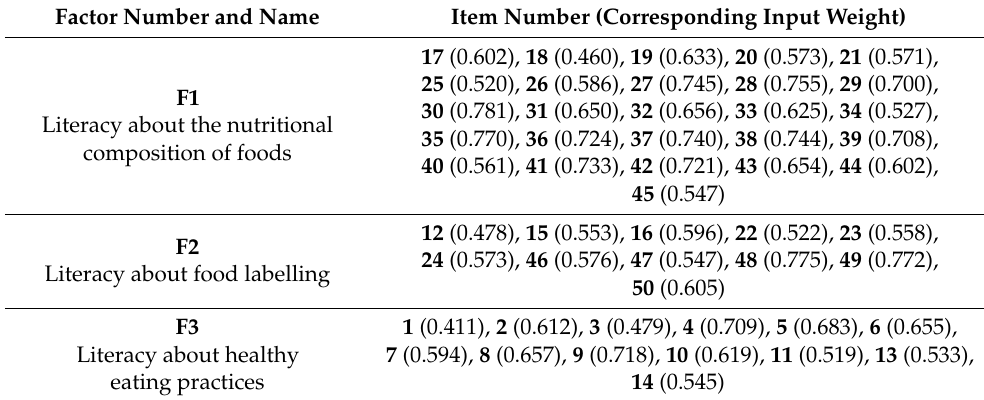
Figure 2. Scree plot for factor analysis through PCA with Varimax rotation. Table 5. Distributions of the items by the